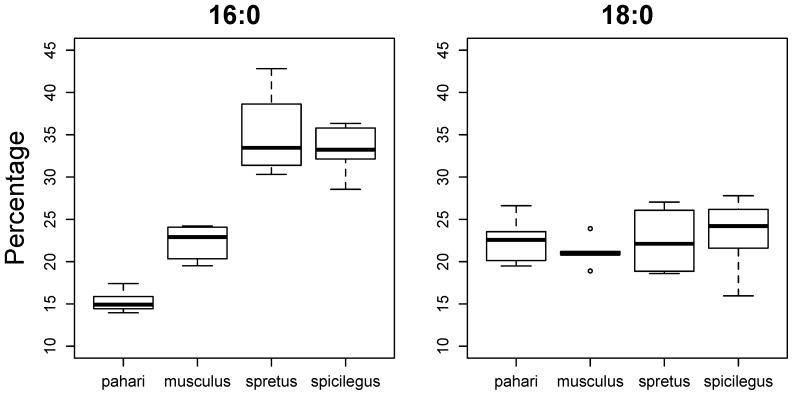
Percentage of the most abundant saturated fatty acids in sperm cells.The two saturated fatty acids that compose more than 5% of the fatty acids in sperm cells are represented. The modified boxplots present the following information: the bar within each box represents the sample median, each box represents 50% of the data around the median, and the two whiskers around each box represent the 95% confidence interval (n = 5 for each species, except n = 4 in the case of sperm data for M. spretus); circles represent outliers.